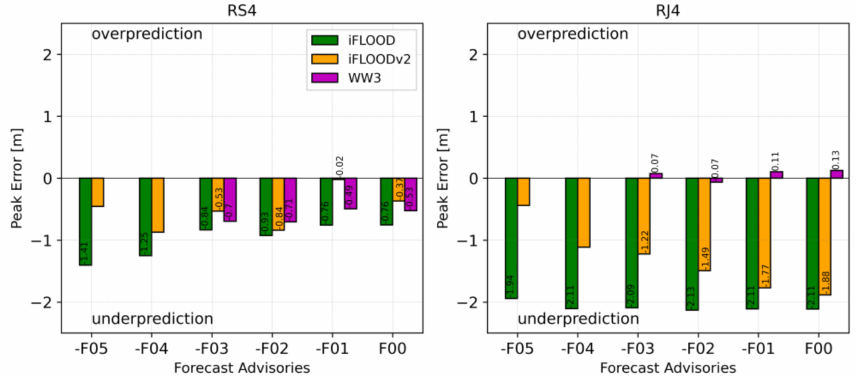
Figure 10. Bar plots of peak errors for maximum wave heights at 3 wave recording stations during the bomb cyclone of 2020. F00 represents the forecast advisory on 1 July at 18:00 UTC, while the bars before F00 represent the forecasts issued earlier at 12 h